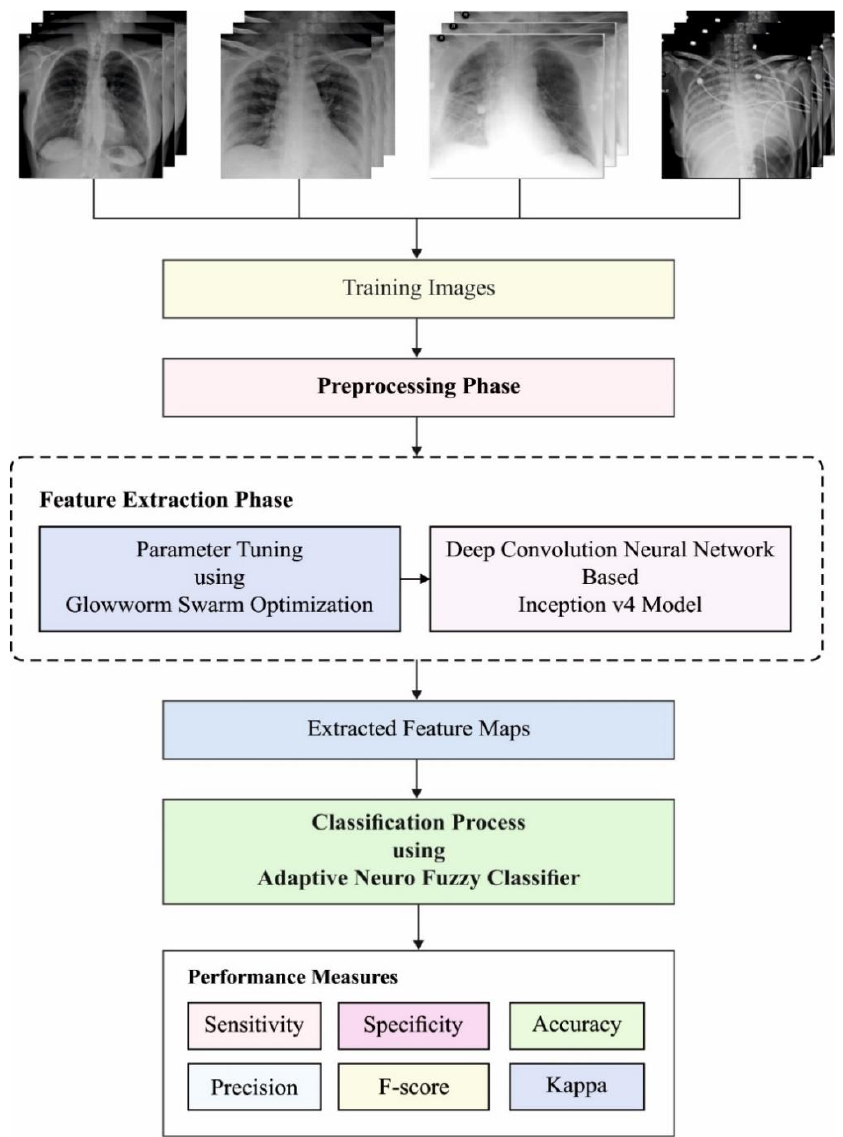
Figure 1. Working process of the GSO-IDCNN model.